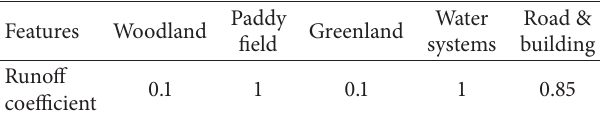
Table 1: Runoff coefficient of different land use features determined according to outdoor drainage design norm of China (GB50014- 2006)